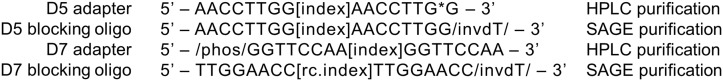
Schematic structural representation of the adapter and blocking oligo sequences and the required modifications.Full-length sequences can be derived from the Illumina sequence letter [11]. Index = sequence of 6–8 nucleotides that makes each adapter unique, * = phosphothiorate bond, /invdT/ = inverted dT, /phos/ = phosphate group, rc. = reverse complement. Oligonucleotide sequences © 2007–2013 Illumina, Inc. All rights reserved. Derivative works created by Illumina customers are authorized for use with Illumina instruments and products only. All other uses are strictly prohibited.